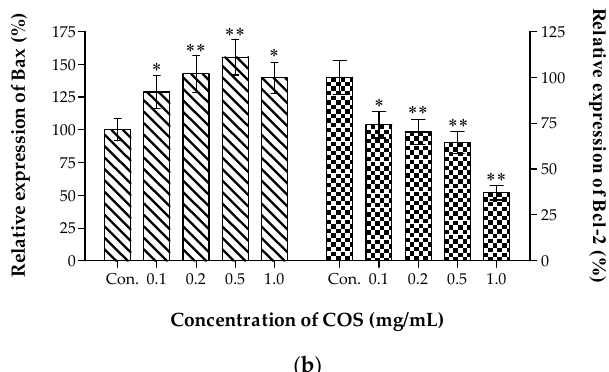
Figure 3. Effects of COS on cell viability and apoptosis of A549. ( a ) Morphological changes of A549 cells with Calcein-AM/PI assay (original magnification, 100×); ( b ) Relative expression of Bax and Bcl-2 with western blotting. Data represents mean ± SD, n = 6, ** p < 0.01 significant difference versus control group.